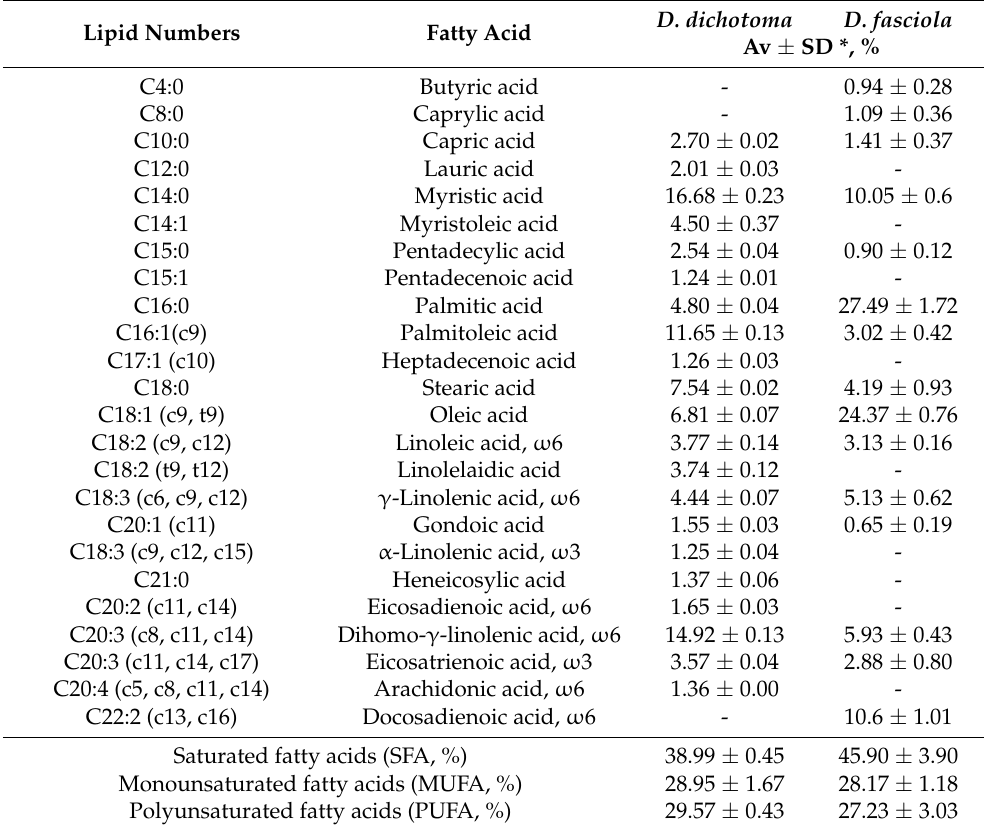
Table 2. Fatty acids composition of D. dichotoma and D. fasciola determined by GC-FID analysis. Lipid